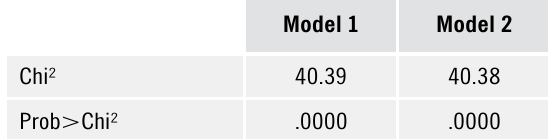
Table 8. The Breusch-Pagan